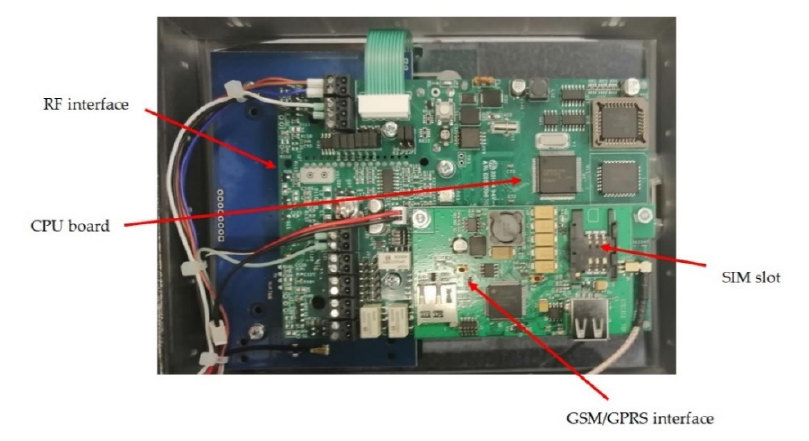
Figure 3. Circuit board housed within the Central Unit. RF interface is in charge of communication between the apparatus and the vaginal probes. The GSM/GPRS interface is in charge of commu- nication between the Central Unit and mobile phones, by means of the mobile phone SIM card placed into the dedicated slot.